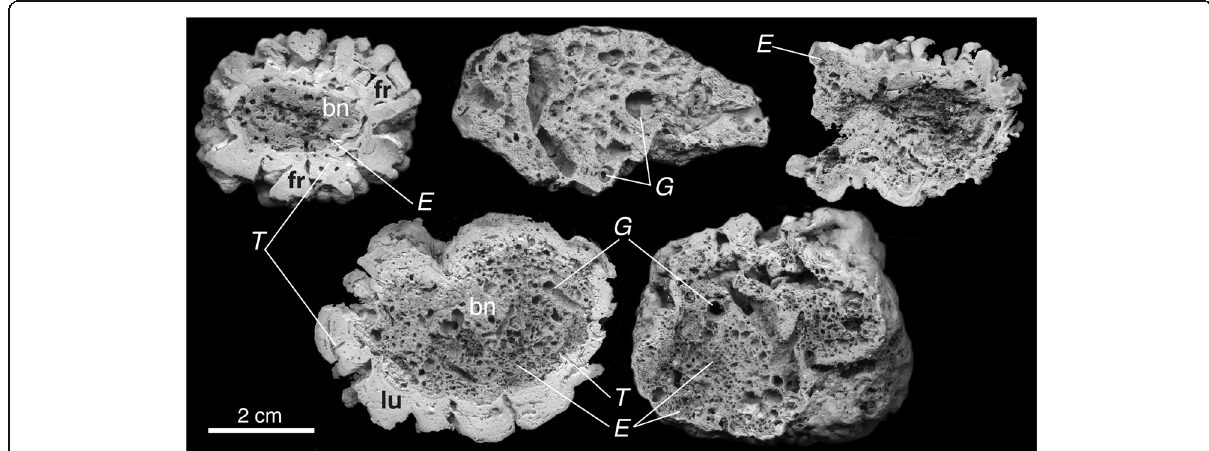
Fig. 3 Slab surfaces of One Tree Reef and Lizard Island rhodoliths showing the bioerosion traces. Note the growth break between the bioeroded nucleus (bn) and the fruticose/lumpy stage (fr, lu). E , Entobia ; G , Gastrochaenolites ; T, Trypanites